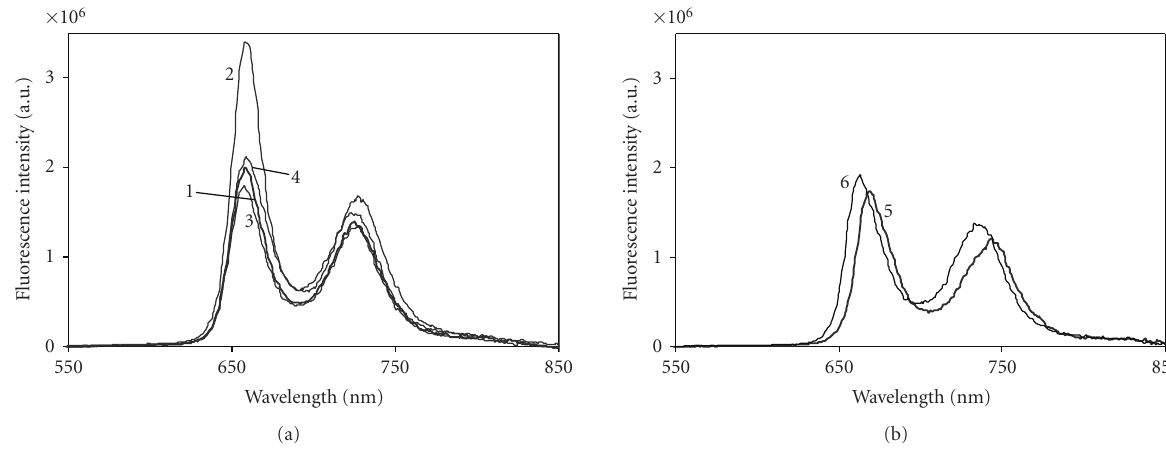
Figure 3: Laser-induced corrected fluorescence emission spectra of (a) TPP ( curve 1 ), TPPOH O (curve 2), TPPOH M (curve 3), and TPPOH P (curve 4) and of (b) TBP ( curve 5 ) and TBPOH O (curve 6) in benzene, at room temperature. The optical density at the excitation wavelength was always 0.30 and the samples were air equilibrated.